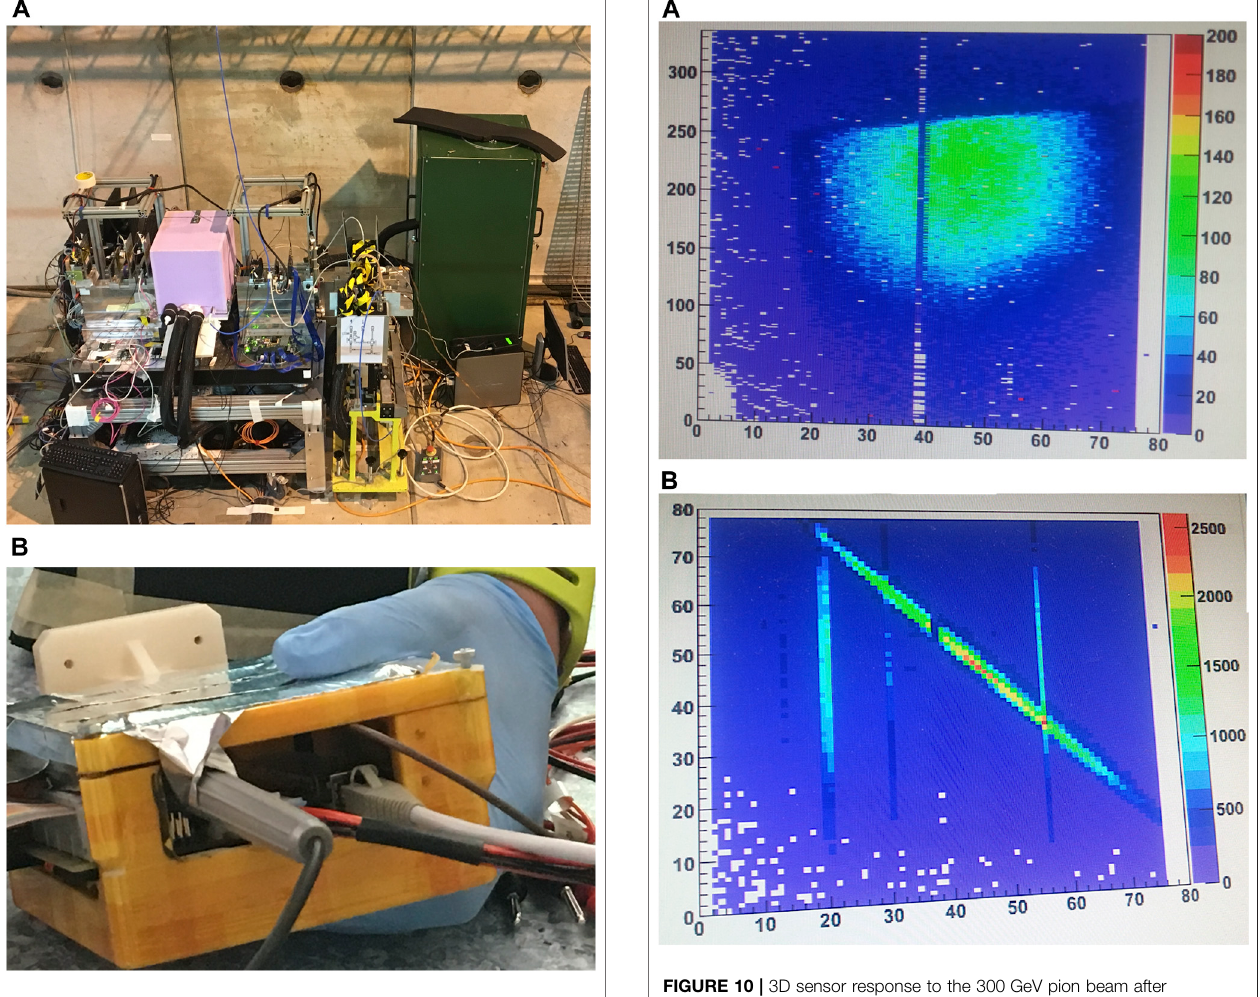
FIGURE 9 | Picture of the test beam setup at the CERN SPS H6 beamline. (A) ATLAS Fe-I4 telescope on the left and the TRACI cooling plant on the right. (B) The 3D printed cooling box hosting the vertically integrated system showing details of the electrical cables.